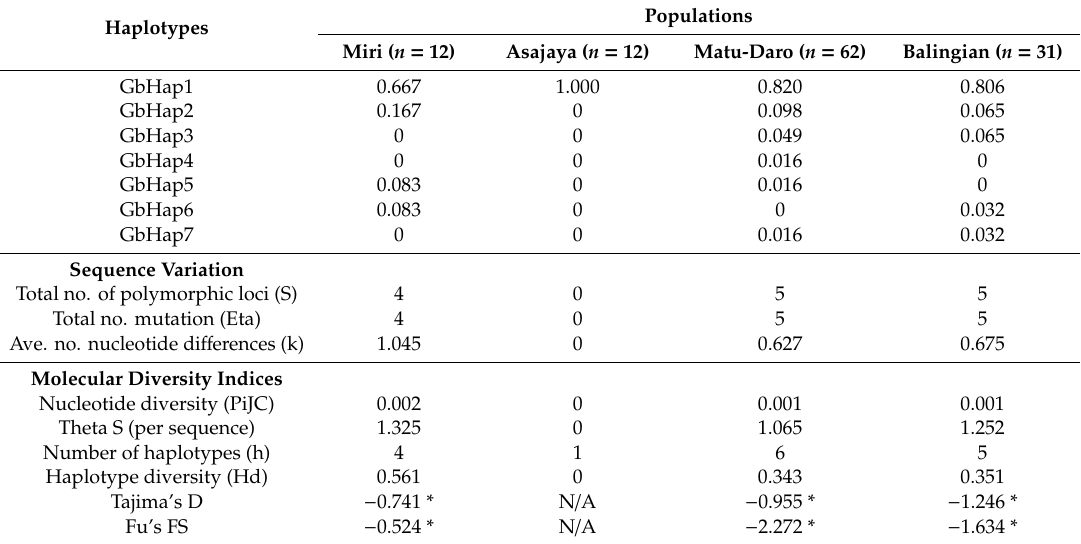
Table 2. Distribution of seven observed haplotypes, sequence variation and molecular diversity indices among populations of G. boninense . Haplotype diversity represent probability that two randomly sampled genes are di ff erent. Nucleotide diversity is the average number of nucleotide di ff erences per site in pairwise comparison among gene sequences. As a single population, Tajima’s D was − 0.9869 * and Fu’s FS was − 2.772